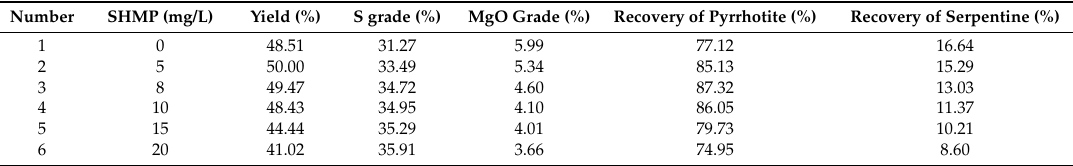
Table 4. Results of the chemical analysis and the recovery of artificially mixed